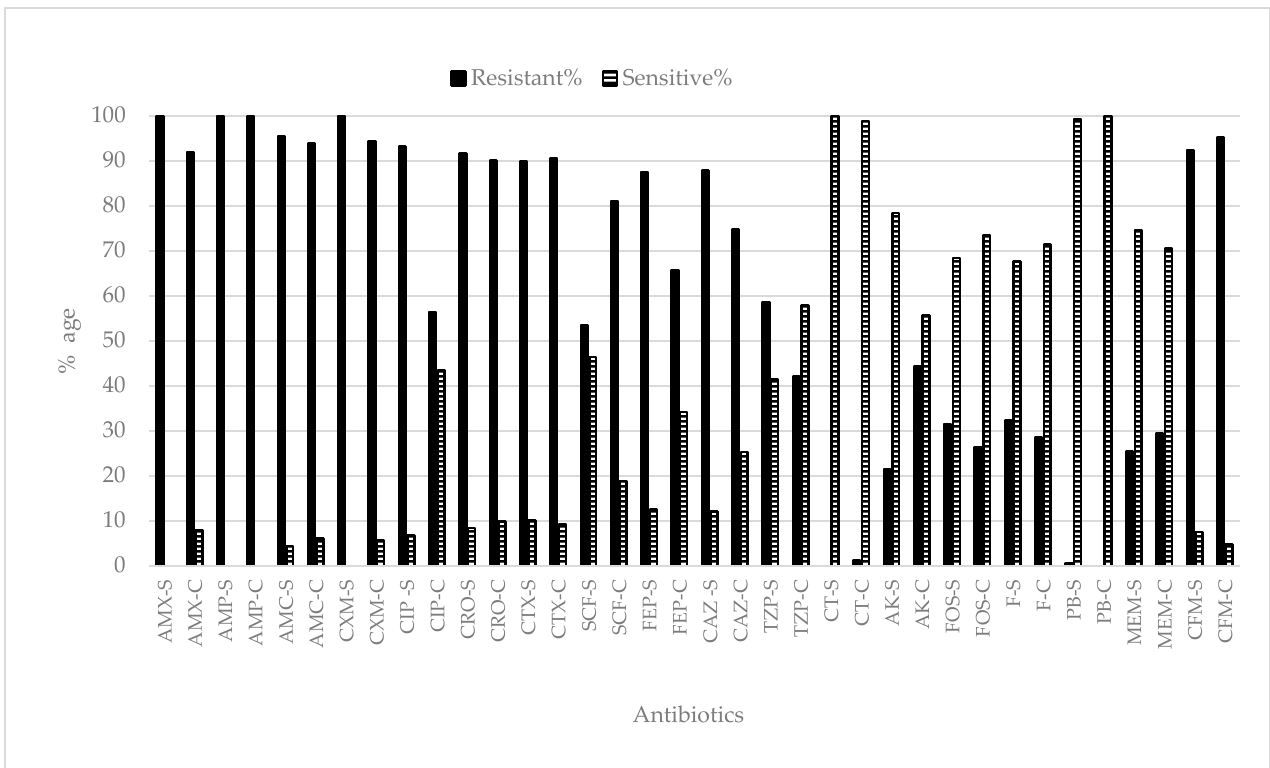
Figure 4. Antibiotic resistance/sensitivity profile of bacterial strains isolated from pediatric patients’ (aged 0–6 years) samples at Shaikh Zayed Hospital and Children Hospital, Lahore, suffering from UTI. Samples from Shaikh Zayed Hospital were represented by suffix “S” and from Children Hospital by suffix “C” .